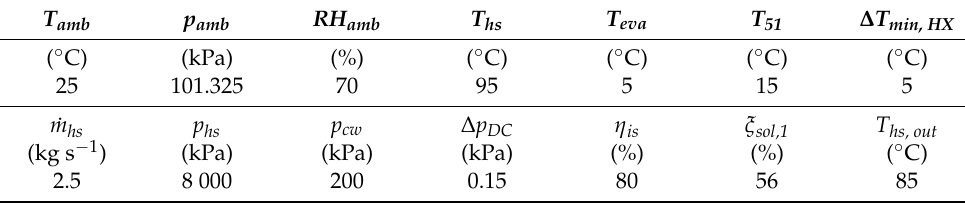
Table 1. Boundary conditions of the